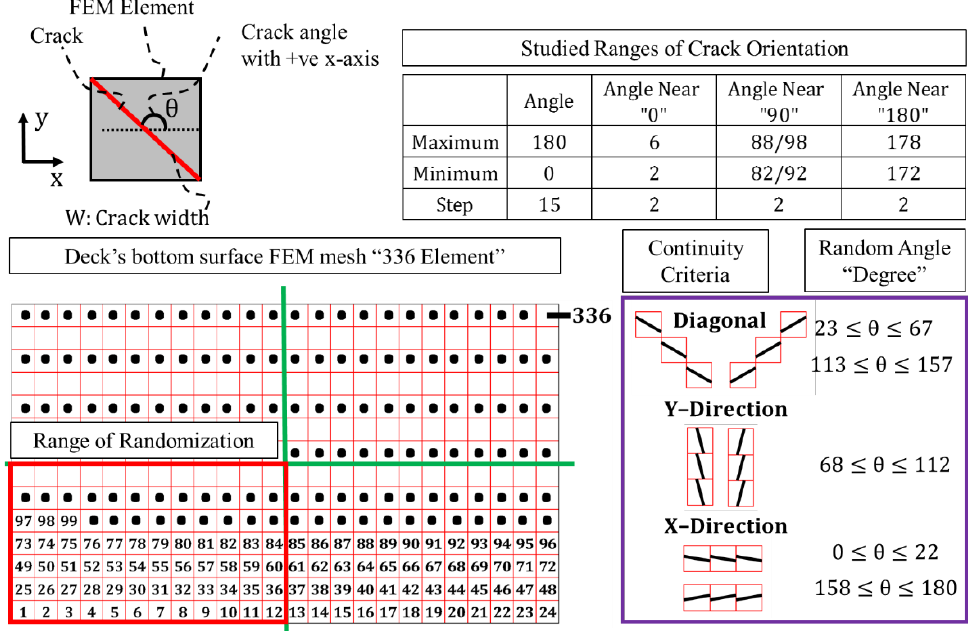
Figure 8. Randomized artificial crack pattern (RACP) scheme.